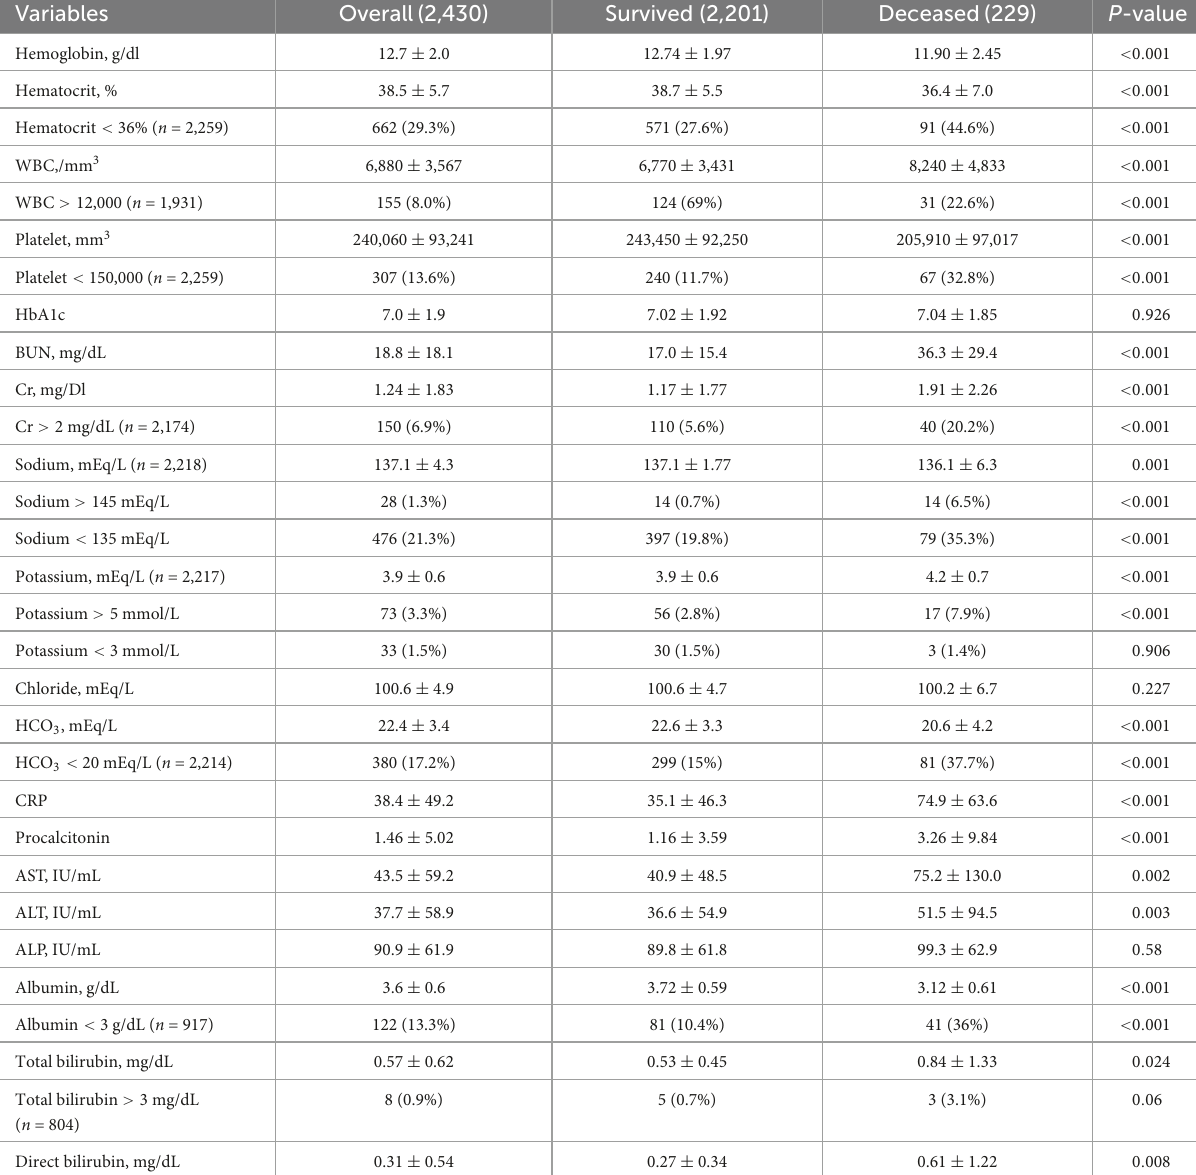
TABLE 2 Baseline laboratory data within 24 h of admission according to hospital